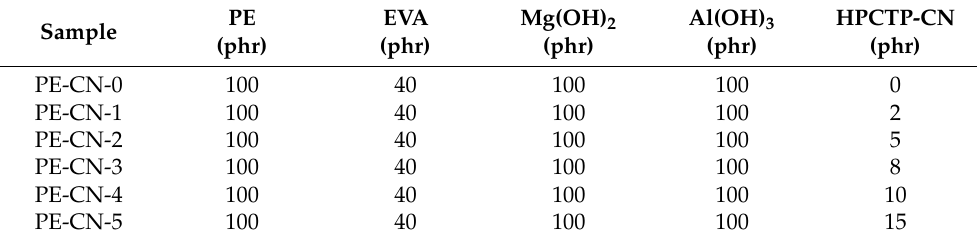
Table 1. Formulation of insulation materials.